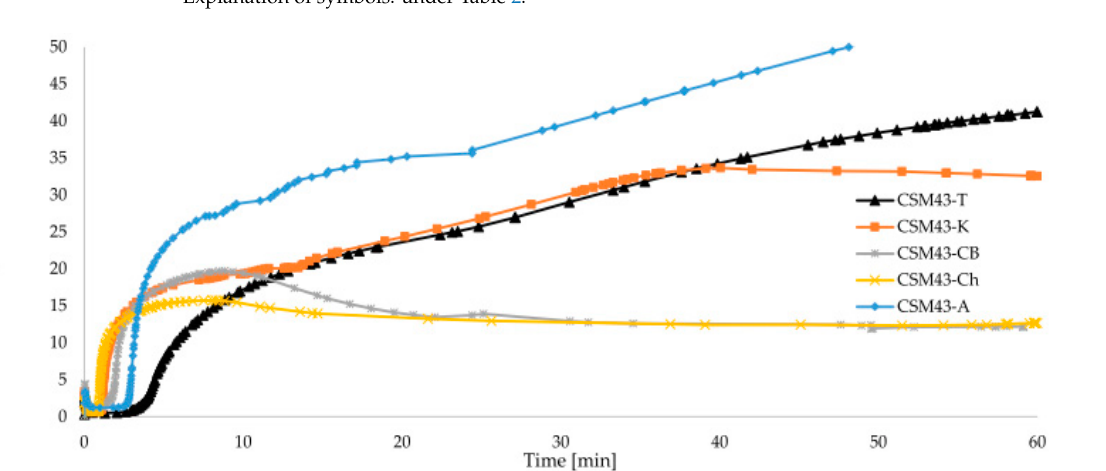
Figure 5. Vulcametric kinetics of filled chlorosulfonated polyethylene cross-linked with iron(II,III) oxide (3 phr of Fe 3 O 4 ).